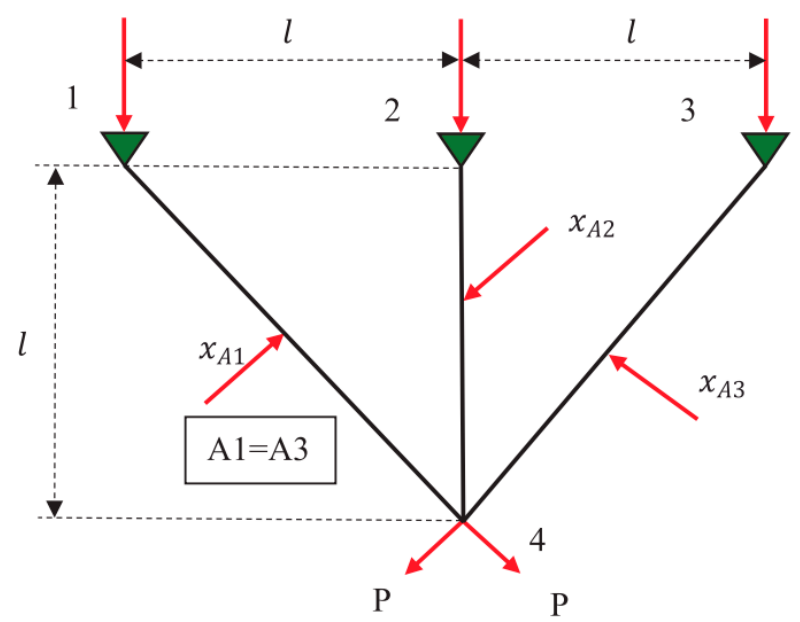
Figure 12. Sketch map of the 3-bar truss design problem.